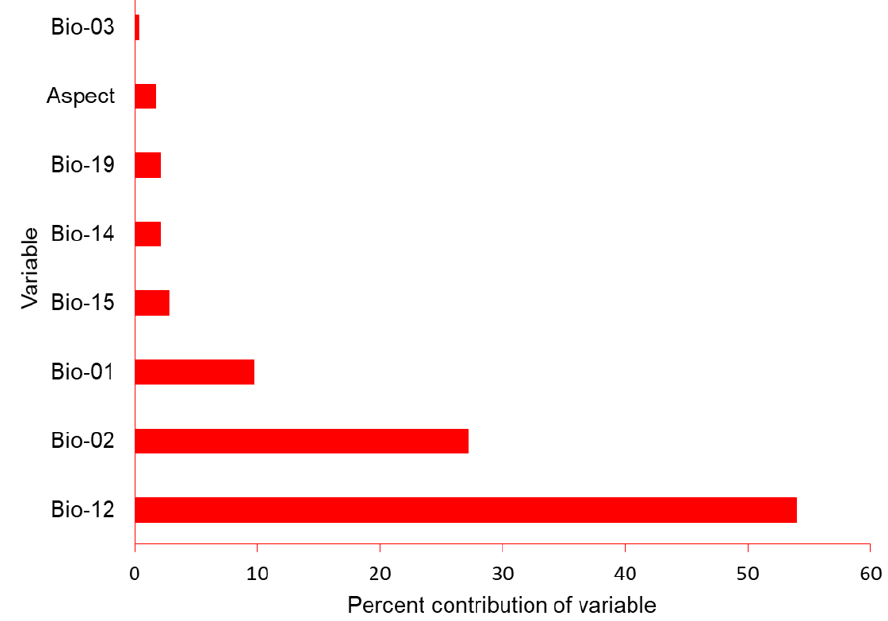
Figure 3. Percent contribution of climactic variables aspect, mean annual temperature (bio_01), mean diurnal range (bio_02), iso-thermality (bio_03), annual precipitation (bio_12), precipitation of wettest month (bio_13), precipitation of driest month (bio_14), precipitation seasonality (bio_15) and precipitation of the coldest quarter (bio_19) for model construction for the potential distribution of suitable nest habitat for Egyptian vultures, Nepal.